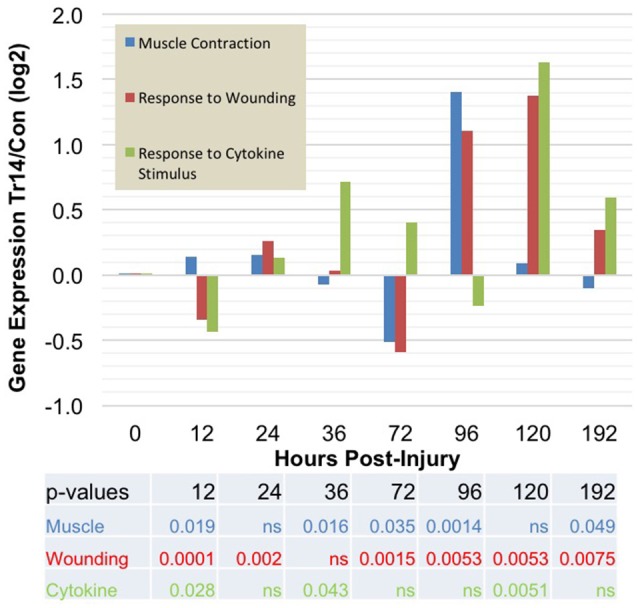
The effect of Tr14 on gene expression patterns after wounding. The RNA sequencing results were analyzed to identify transcripts that were differentially expressed between placebo-treated controls and Tr14-treated wounds, at each time point after injury (X axis). The effect of Tr14 on a given ontology is shown as an aggregate gene expression score of the differentially expressed transcripts in that GO group, expressed as the log2 ratio of the Tr14 vs. control levels, (Y axis, log2 ratio Tr14/Con). For the Muscle Contraction GO, a total of 25 transcripts were affected covering 17 unique, non-redundant genes. Tr14 affected 87 transcripts (51 genes) in the Response to Wounding GO, and 9 transcripts (6 genes) in the Response to Cytokine Stimulus GO.